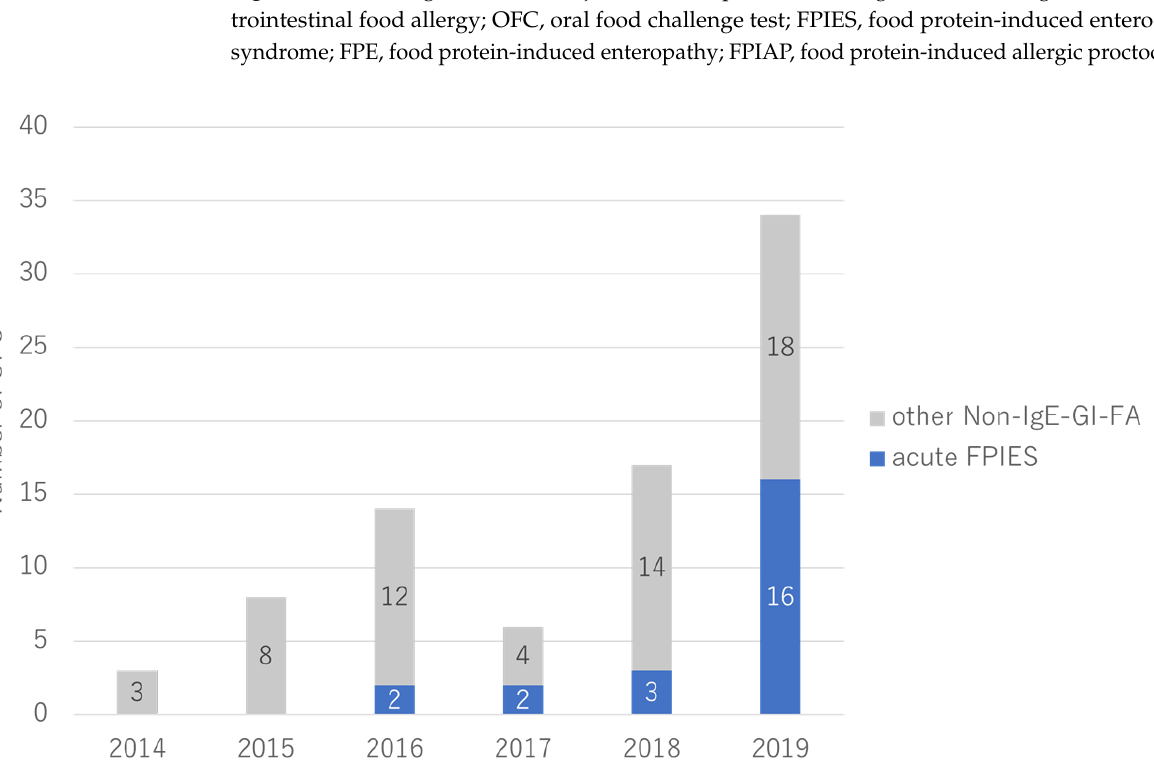
Figure 2. The distribution of follow-up OFC for acute FPIES and other non-IgE-GI-FA in our hospital in six years. Non-IgE-GI-FA, non-IgE-mediated gastrointestinal food allergies; OFC, oral food